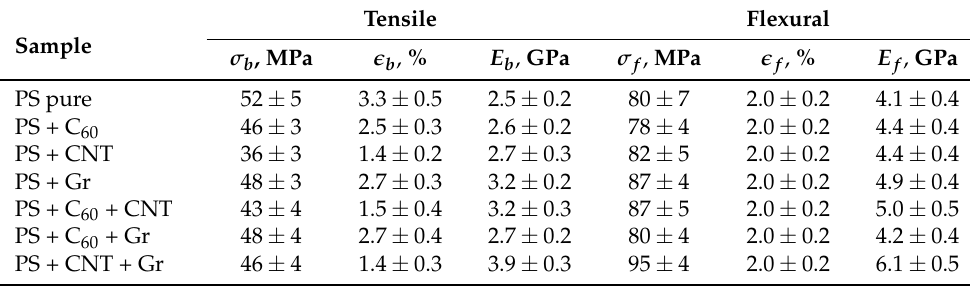
Table 1. Linear elastic parameters of PS-based nanocomposites obtained from tensile and flexural tests. Tensile Flexural Sample σ b , MPa (cid:101) b ,